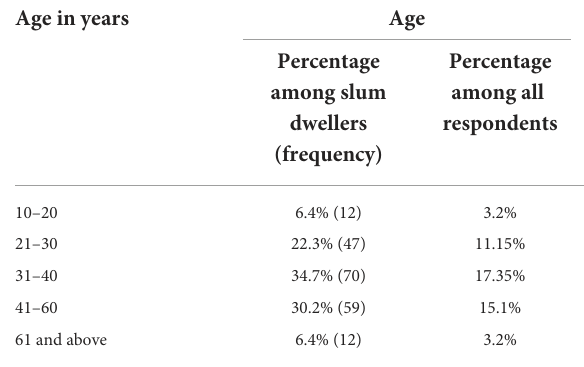
TABLE 1 Socio-demographic Information of all respondents regarding gender and age. Variables and outcome